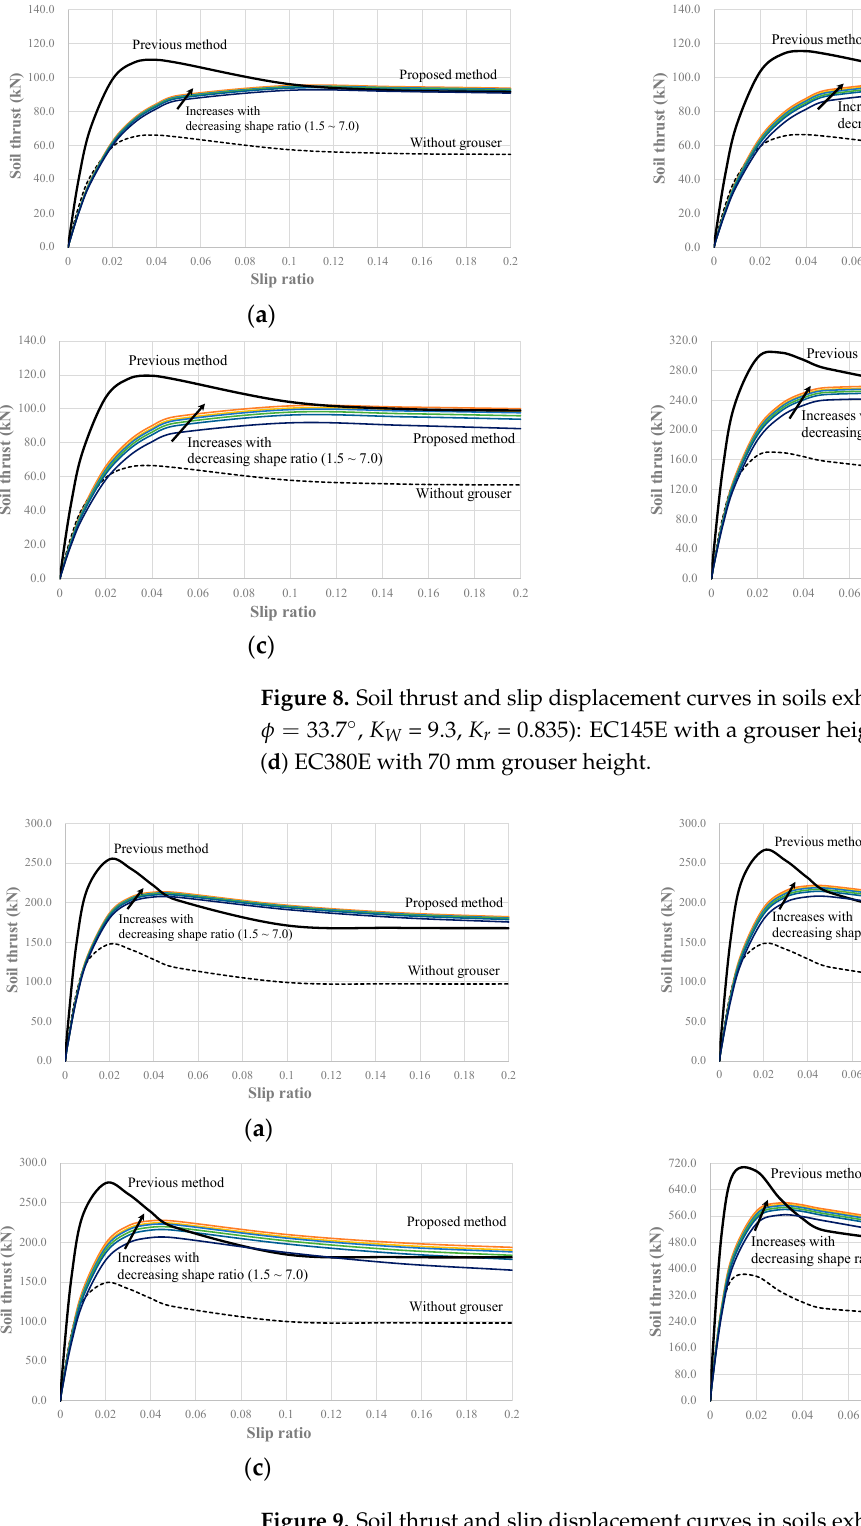
Figure 7. Soil thrust and slip displacement curves in soils exhibiting hardening behavior ( c = 1.39 kPa, 𝜙 = 30.6° , K = 1.13): EC145E with a grouser height of ( a ) 25 mm, ( b ) 50 mm ( c ) 70 mm: ( d ) EC380E with 70 mm grouser height.